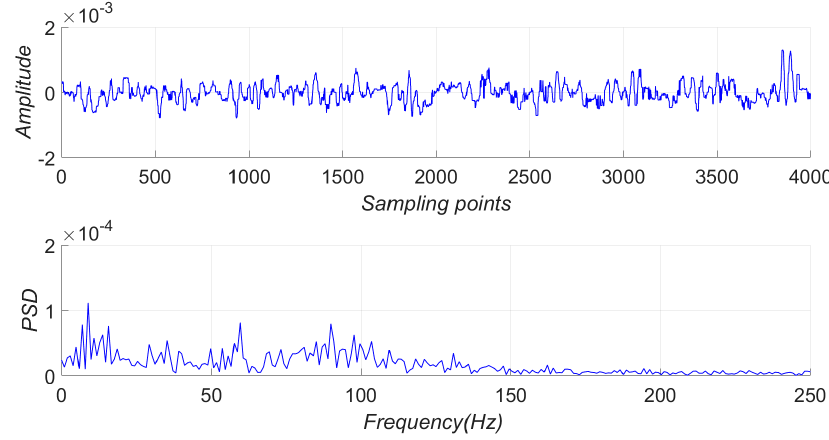
Figure 23. Time domain waveform and PSD of the tapping signal at 85 m. The tapping signal at 97 m was easier to discern than that at 85 m in the time domain. The bins at 97 m between 50 Hz and 100 Hz were higher than the other bins. Therefore, the characteristic frequency of tapping was in the range of 50–100 Hz. The bins at 85 m between 50 Hz and 100 Hz seemed to be higher than other bins, but it was not obvious. The approximate SNRs from 84 m to 108 m are shown in Figure 24. The signal at 97 m was closest to the vibration source, so it had a high SNR. The signal at 85 m or 108 m was far from the vibration source, so it had a low SNR.